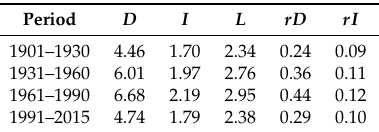
Table 1. Average values of severity ( D ), intensity ( I ), length ( L ), relative severity ( rD ) and relative intensity ( rI ) of deficit events derived from simulated data.